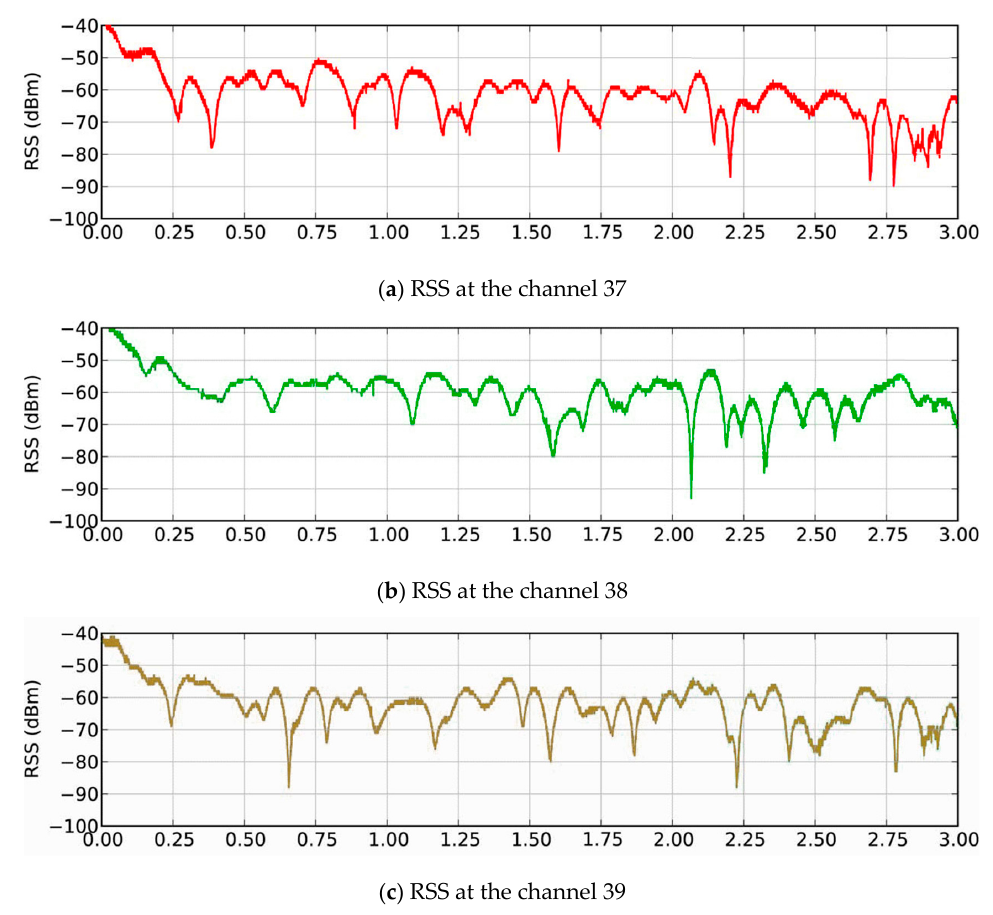
Figure 1. Examples of RSS variation at the channels ( a ) 37, ( b ) 38, and ( c ) 39.